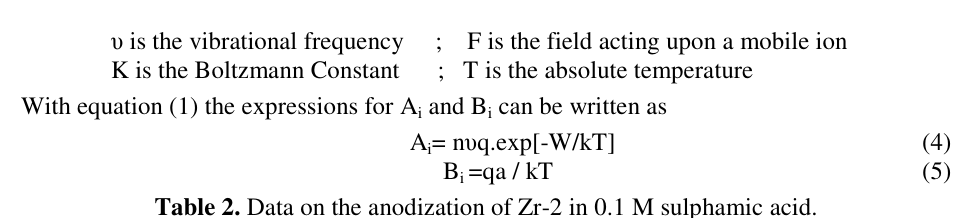
Table 2. Data on the anodization of Zr-2 in 0.1 M sulphamic acid.